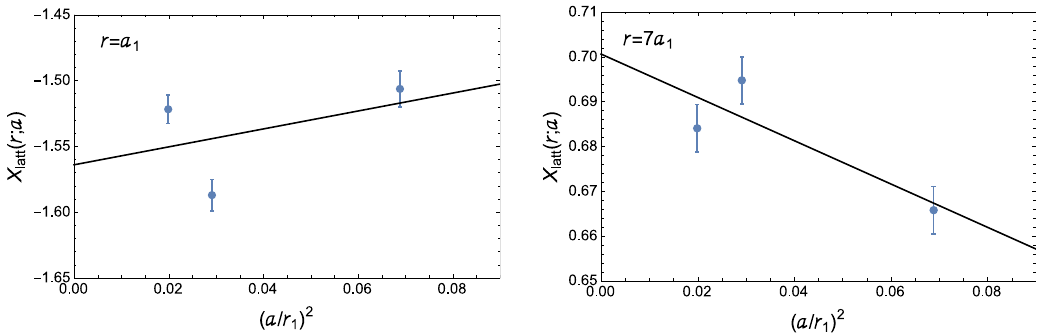
Figure 15 . X latt ( r ; a ) as functions of ( a=r 1 ) 2 when we include r = a in interpolation. We show them for r = a 1 (left) and r = 7 a 1 (right), which are reference distances for d = 1. Black lines are linear functions in a 2 determined by (cid:12)ts. (cid:31) 2 = d : o : f : , which is the reduced (cid:31) 2 in this extrapolation, ex are 20 (left) and 4 : 3